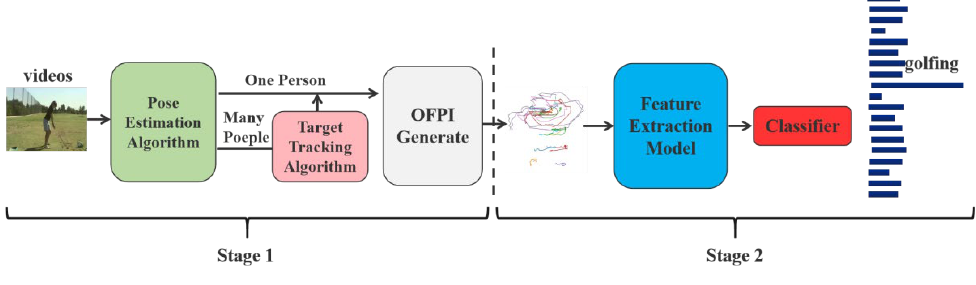
Figure 1. The overall pipeline of our action recognition method.